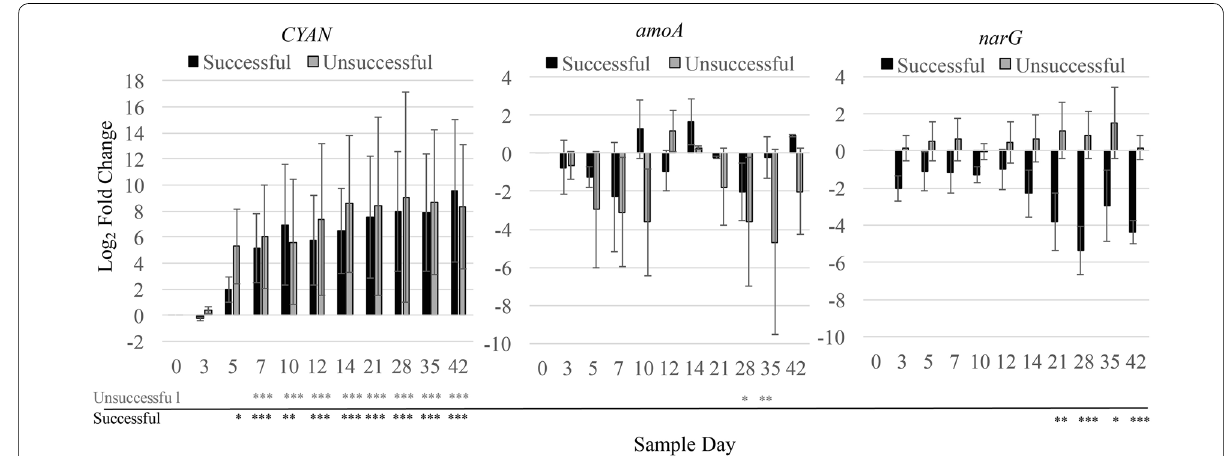
0 day community. R 2 =